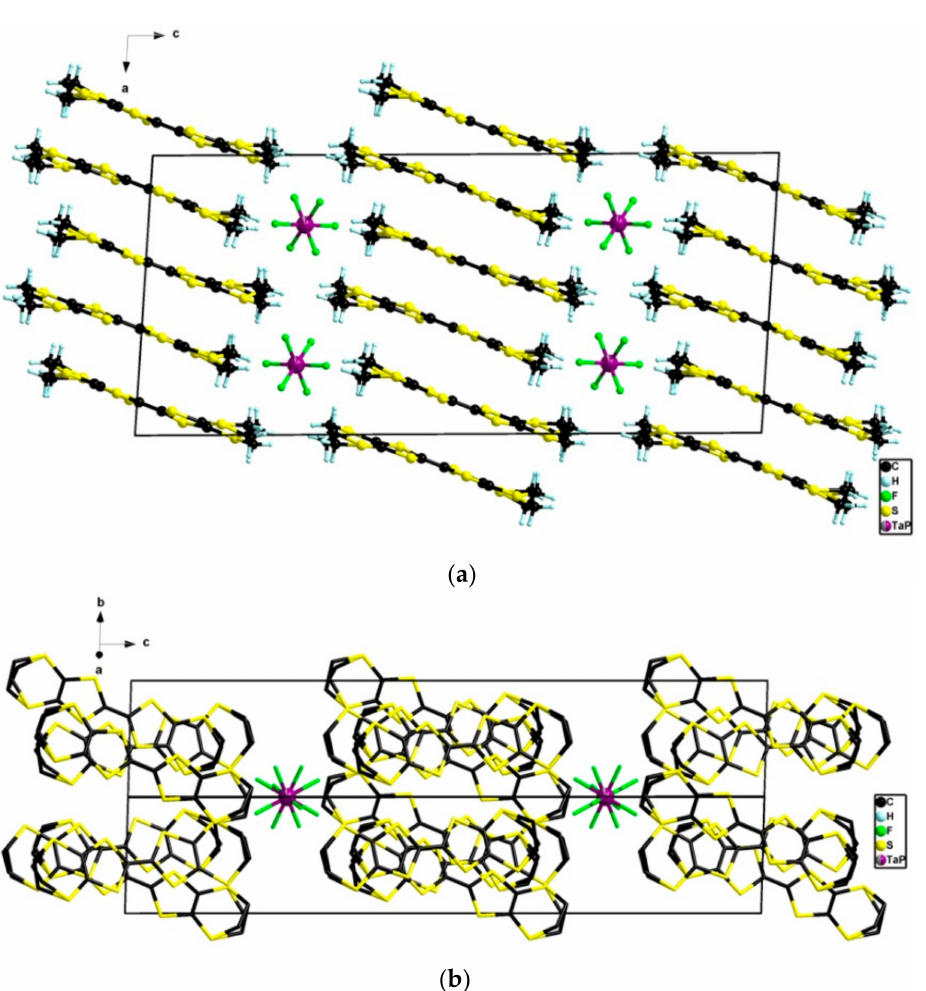
Figure 7. View of the packing in the ac plane ( a ) and in the bc plane ( b ) in the structure of δ m -(BEDT- TTF) 2 (TaF 6 ) 0.94 (PF 6 ) 0.06 .